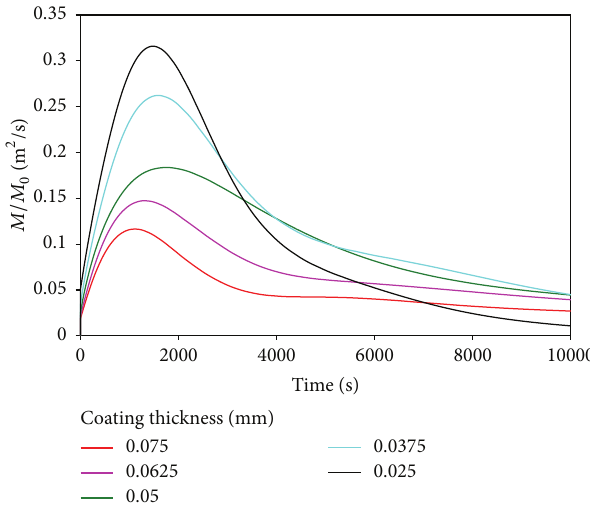
Figure 4: Influence of coating thickness on drug concentration into the artery